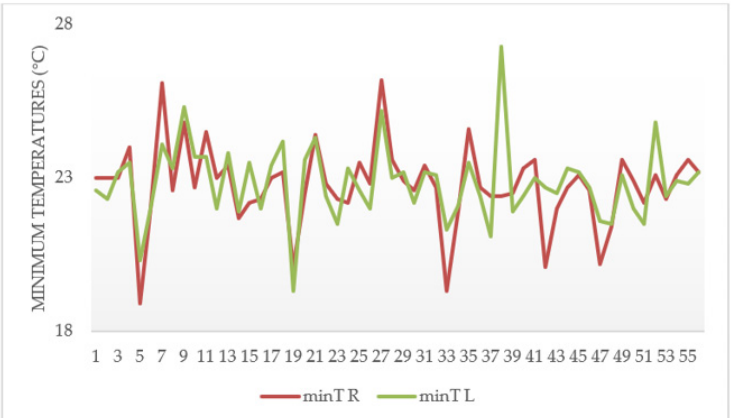
Figure 9. Graphs of minimum temperature differences between minT R (right wrist minimum tem- perature) and minT L (left wrist minimum temperature) points of subjects from the sanding area.